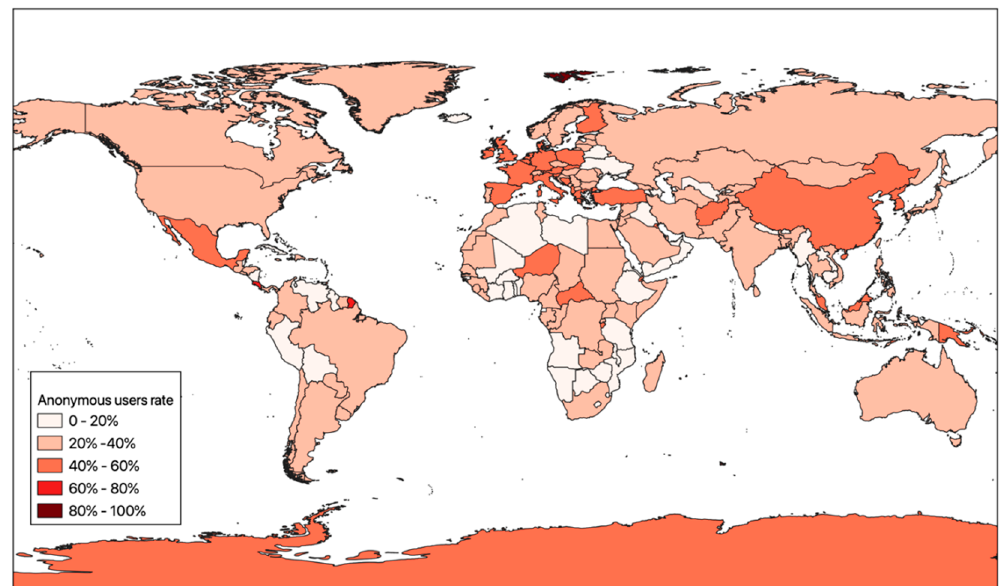
Figure 10. Distribution rates of open / closed OSM Notes posted by anonymous users.